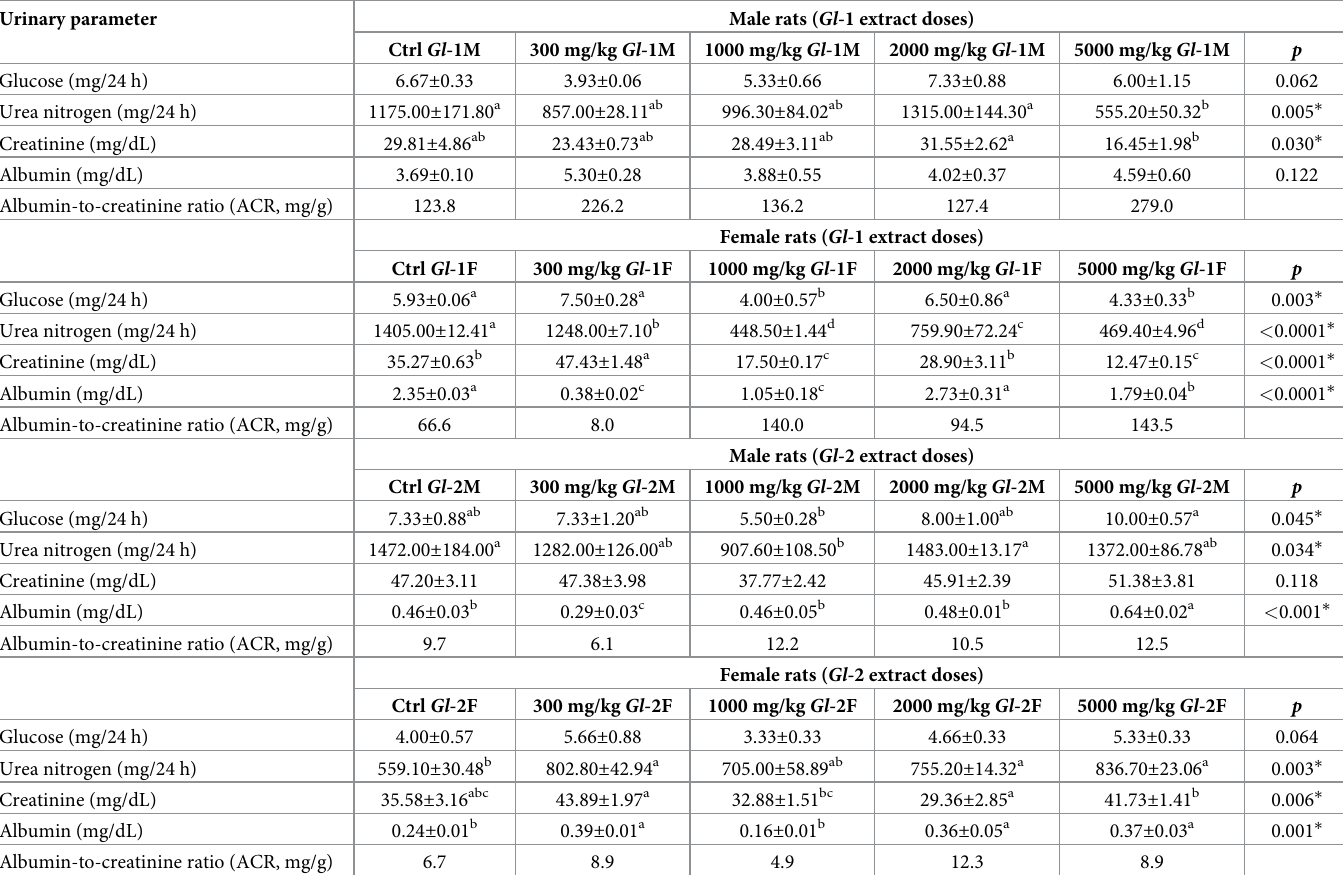
Table 3. Average data from urinary biochemical parameters of male (M) and female (F) Wistar rats studied, after 14 experimental days. Rats were fed with the con- trol diet and different doses of standardized Gl -1 or Gl -2 extracts from Ganoderma lucidum . Urinary